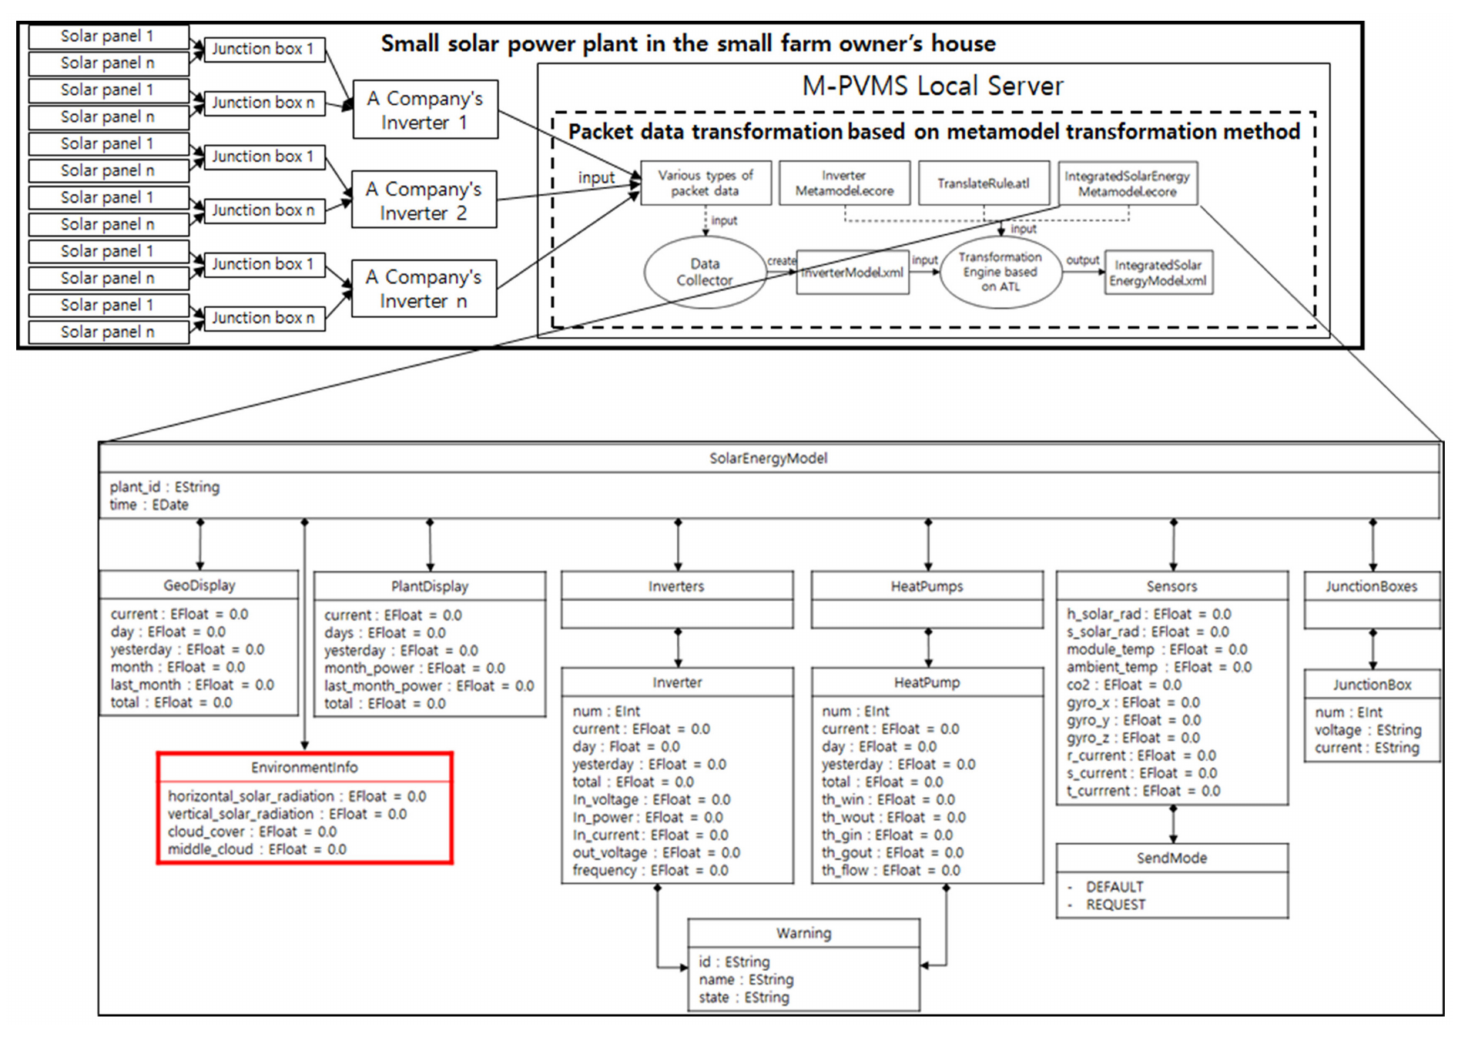
Figure 9. Improved M-PVMS metamodel with environmental